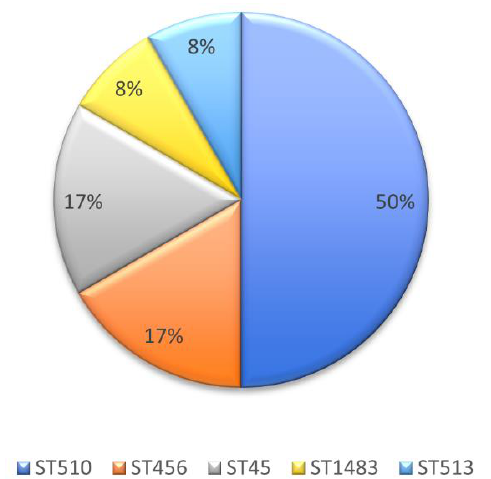
Figure 2. Percentage of sequence types (STs) of the E. cloacae complex isolates carrying the bla KPC-2 gene circulating in the municipality of Santiago de Cali from 2013 to 2018.